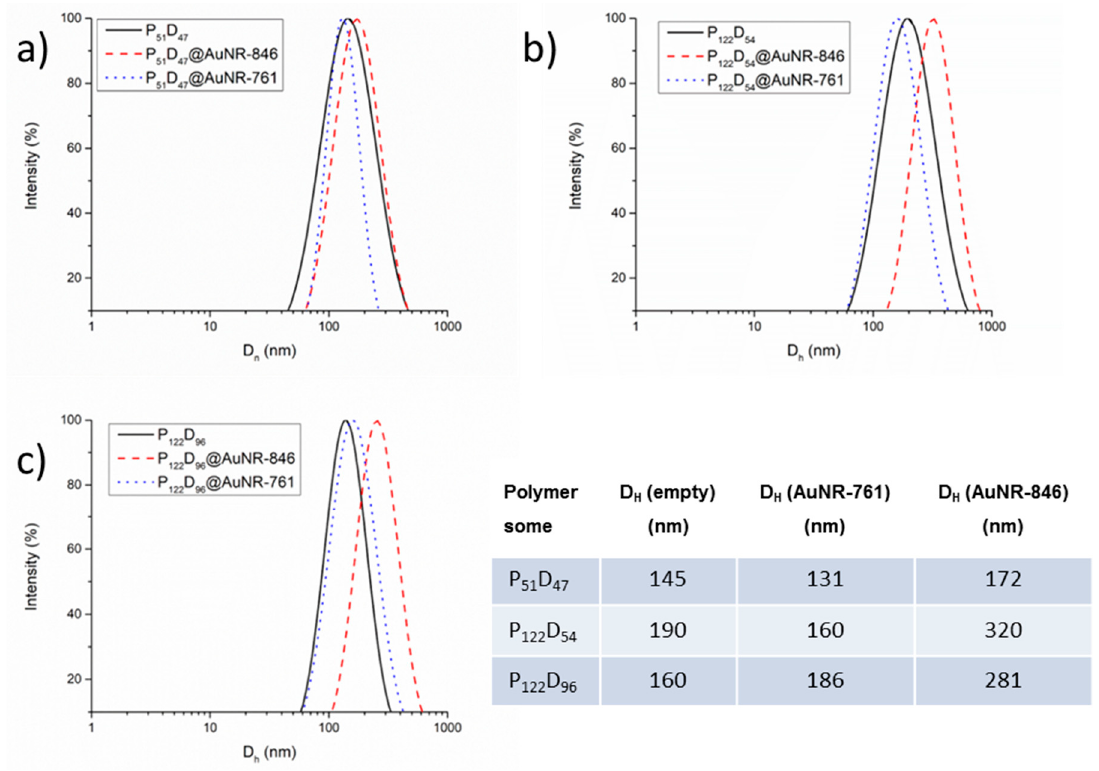
Figure 9. Comparison between the D H of empty polymersomes and AuNR-846/AuNR-761 loaded polymersomes in PBS at pH 7.4: ( a ) from P 51 D 47 , ( b ) P 122 D 54 , ( c ) and P 122 D 96 . Table 3. DOX loading e ffi ciency (DLE DOX ) and DOX loading content (DLC DOX ) and equivalent values for AuNR loadings calculated for the obtained polymersomes.